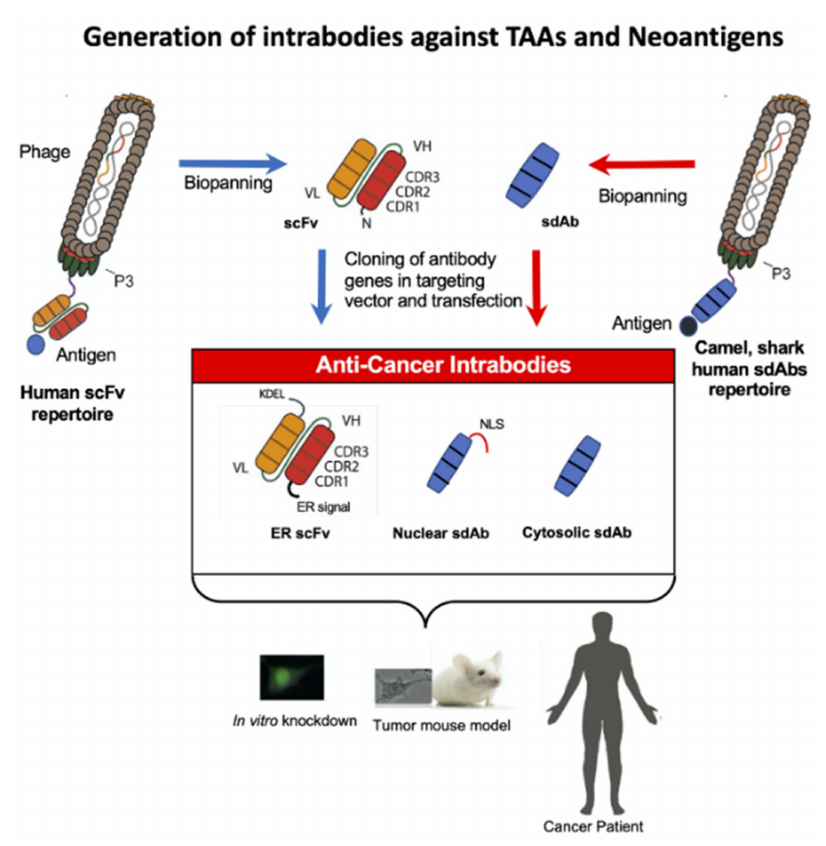
Figure 1. Schematic overview of phage display technology for the generation of intrabodies in cancer